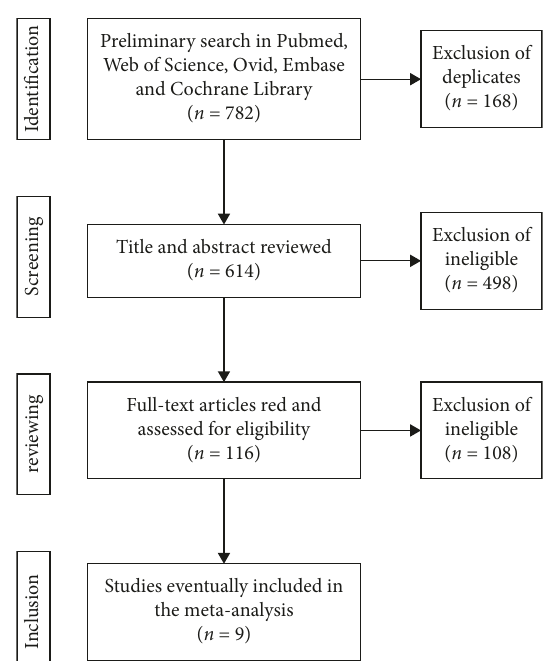
Figure 1: Schema flow of search strategy and history to compare the efficacy of high-dose and low-dose